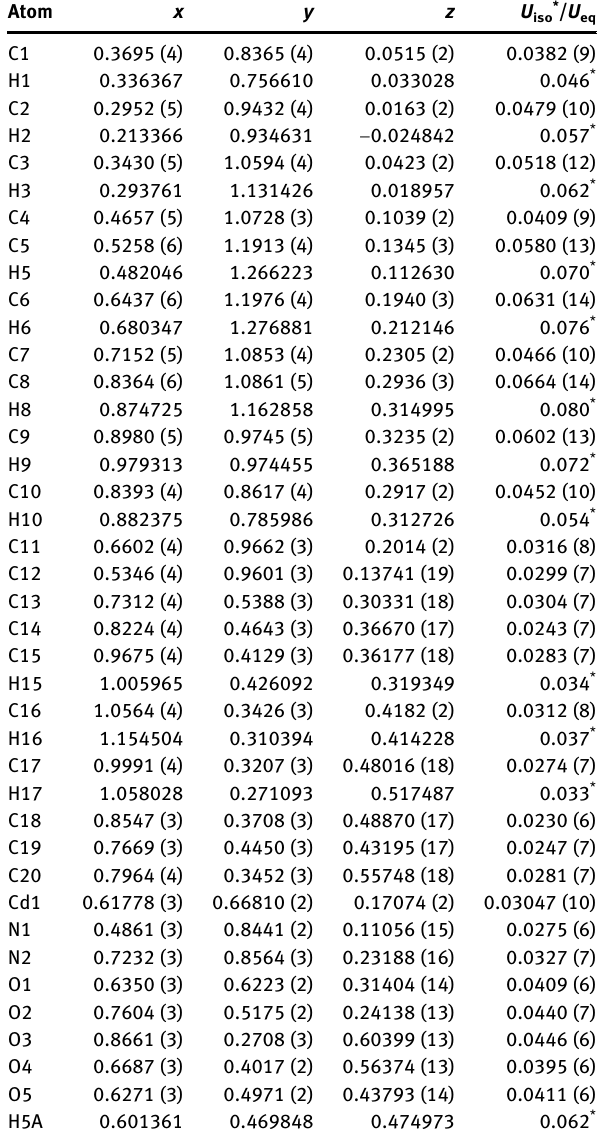
Table  : Fractional atomic coordinates and isotropic or equivalent isotropic displacement parameters (Å 